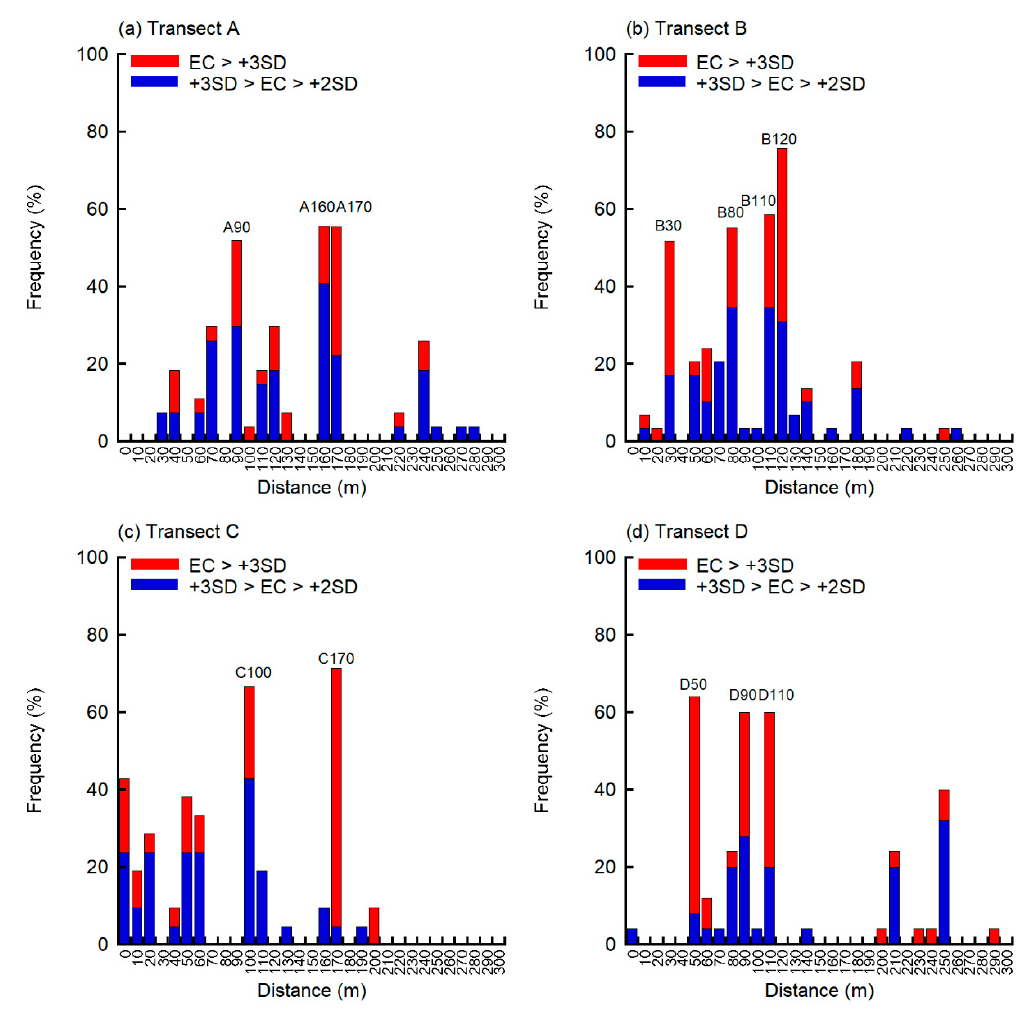
Figure 3. Frequency of precipitation events at every sampling point that throughfall showed extremely high value of EC (EC > + 3SD; + 3SD > EC > + 2SD) along transects A, B, C, and D in the Sanri-Matsubara Forest, northern Kyushu, Japan. Hot spots of sea salt deposition (see text) are shown as the code of combination of transect name and distance over the bar. EC: electric conductivity; SD: standard deviation